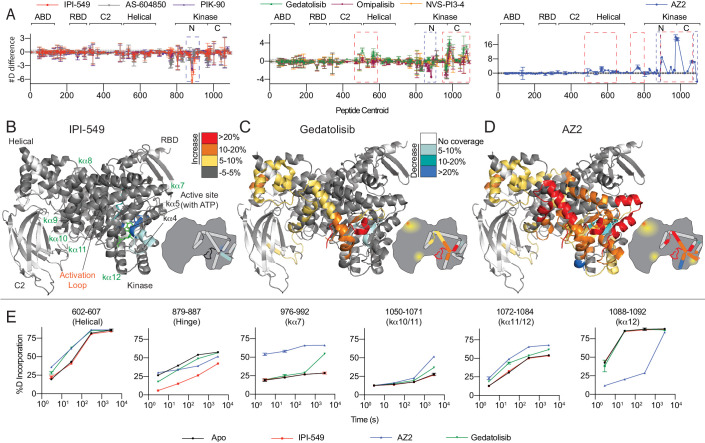
HDX-MS reveals that different classes of PI3K inhibitors lead to unique allosteric conformational changes.(A) The number of deuteron difference for the seven different inhibitors analysed over the entire deuterium exchange time course for p110γ. Every point represents the central residue of an individual peptide. The domain location is noted above the primary sequence. Error is shown as standard deviation (n = 3). (B–D) Peptides showing significant deuterium exchange differences (>5%,>0.4 kDa and p<0.01 in an unpaired two-tailed t-test) between wild-type and IPI-549 (B), Gedatolisib (C), and AZ2 (D) are coloured on a model of p110γ (PDB: 6AUD). Differences in exchange are mapped according to the legend. A cartoon model in the same format as Figure 1 is shown as a reference. (E) Selected p110γ peptides that showed decreases and increases in exchange are shown. The HDExaminer output data and the full list of all peptides and their deuterium incorporation is shown in the Figure 4—source data 1 file.
Figure 4—source data 1.Source data for HDX-MS comparing free p110g with and without inhibitors.